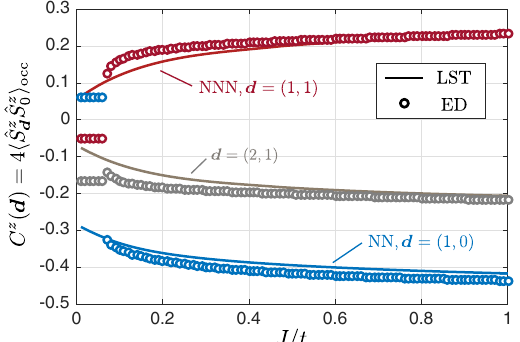
ˆ ˆ S z 0 i S z FIG. 23. Spin-spin correlation functions C z ð d Þ ¼ 4 h in occ d a weakly doped t - J model. We compare results by exact diagonalization of one hole in a 4 × 4 system with periodic boundary conditions to predictions from LST based on the strong-coupling wave function Eq. (57). The correlators are evaluated only for states where both sites 0 and d are occupied by spins, as indicated by the notation h(cid:6) (cid:6) (cid:6)i . In the ED occ − 1 /2 and simulate the sector with calculations we set S z tot ¼ total conserved momentum of k ¼ ð π /2 ; π /2 Þ